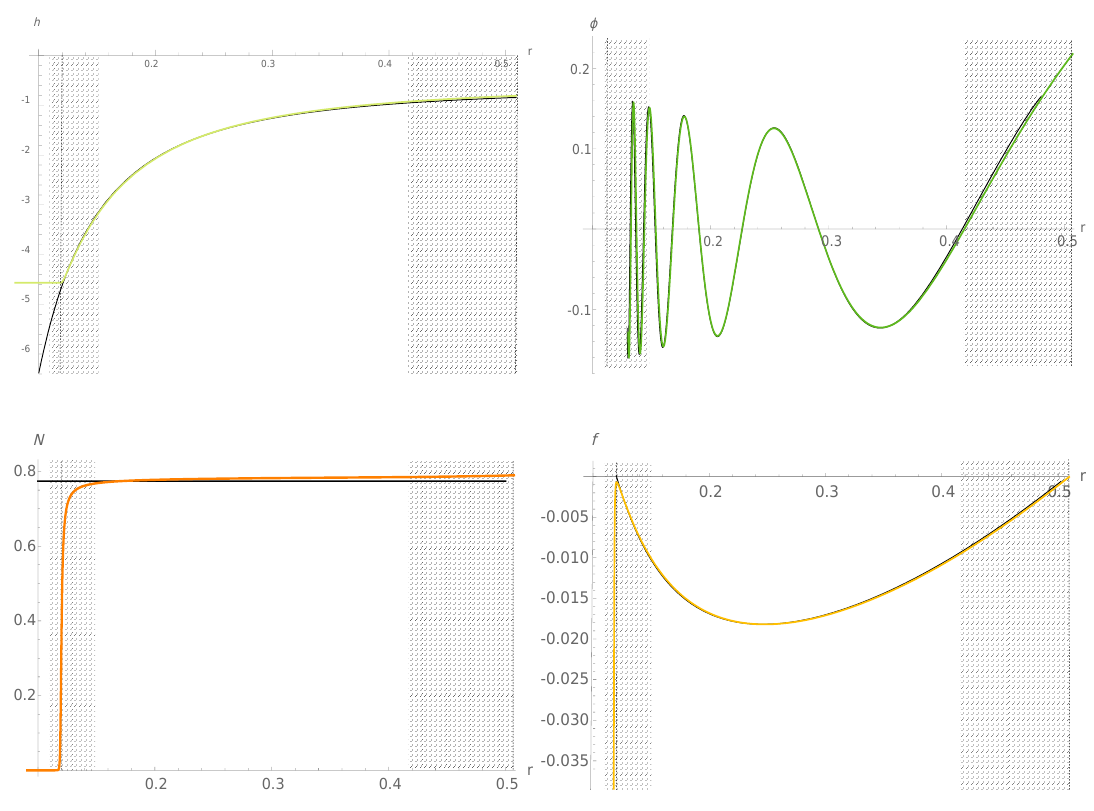
Figure 4 . Full non linear numerical evolution (colour) and probe approximations (4.1) and (4.8)– (4.10) (black) of the profiles in the probe epoch. The dashed regions have been excluded from the fitting. That on the right of each plot interpolates to the polynomial approximation of the previous subsection, while the one on the left connects to the collapse of the Einstein-Rosen bridge described below. The dashed line at large r corresponds to the black hole horizon, while that at small r signals the position of the would-be Cauchy horizon. The values of the parameters correspond to the black hole shown in figure 1